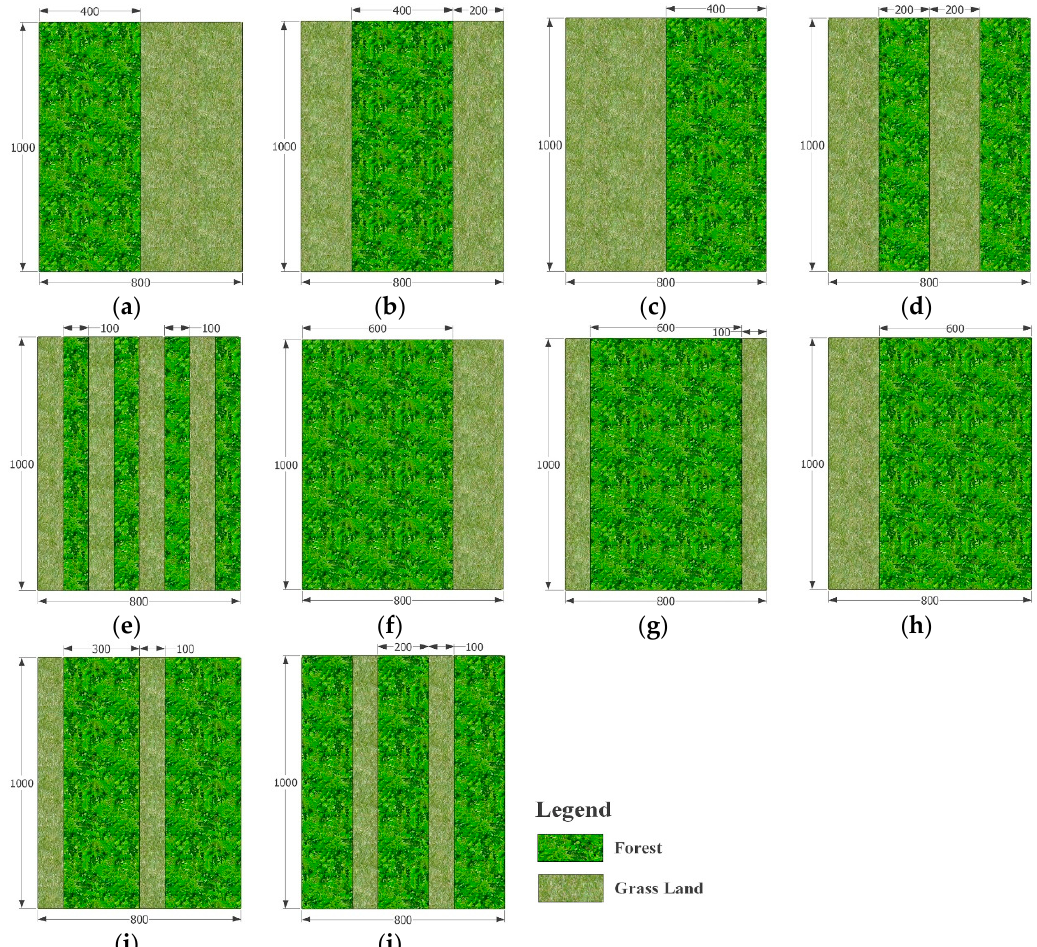
Figure 13. Different vegetation cover patterns on the left hand of slope in the V-shaped catchment (unit: m). ( a ) Case 1; ( b ) Case 2; ( c ) Case 3; ( d ) Case 4; ( e ) Case 5; ( f ) Case 6; ( g ) Case 7; ( h ) Case 8; ( i ) Case 9; ( j ) Case 10.